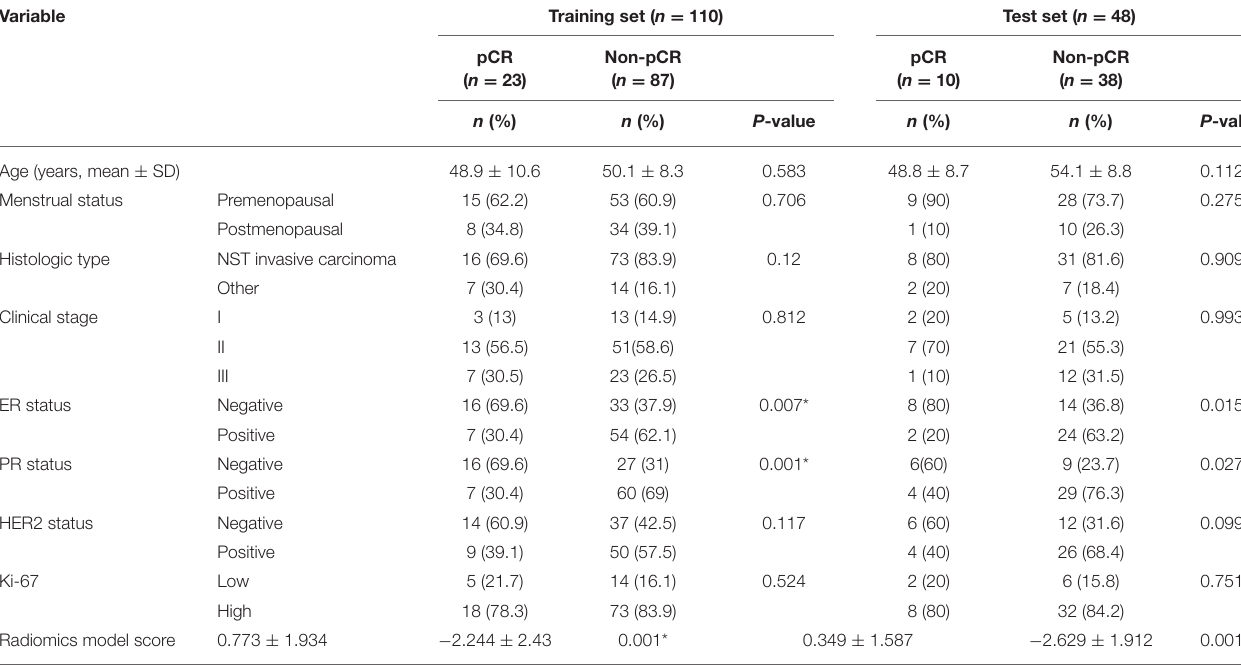
TABLE 2 | Clinical characteristics of the training and validation sets of breast cancer (BCa) patients with and without pCR. Variable